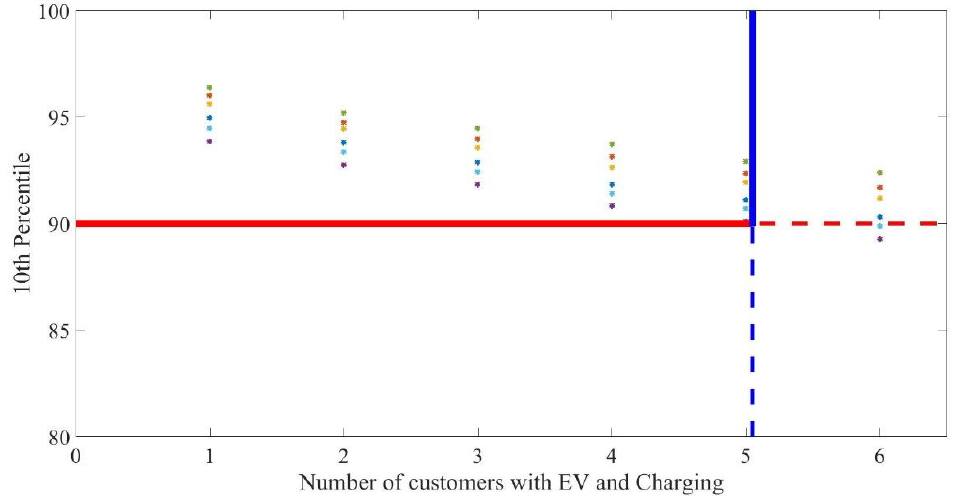
Figure 5. The 10th percentile voltage magnitude for the six customers is obtained from Figure 4 (colored dots) and the 90% undervoltage limit (solid red line).